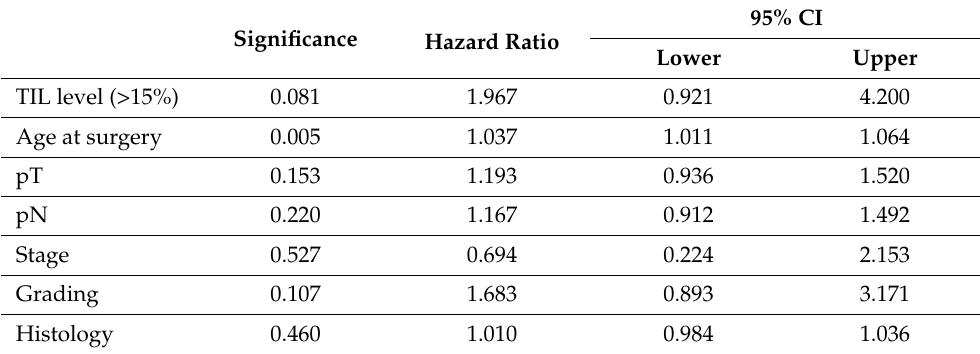
Figure 4. Kaplan–Meier survival analyses of TIL density, according to the Salgado score, revealed significant differences in OS. Patients with TIL levels greater than 15% showed significantly reduced OS (mean 8.6 years) compared with patients with lower TIL levels (mean OS 10.4 years; p = 0.020). However, as shown in Table 2, multivariate Cox regression did not identify the level of TILs as an independent prognostic factor for OS (HR 1.967, 95%CI 0.921–4.200, p = 0.081). Only age at surgery was significant. Table 2. Multivariate Cox regression analysis of TIL levels (Salgado score) regarding OS.